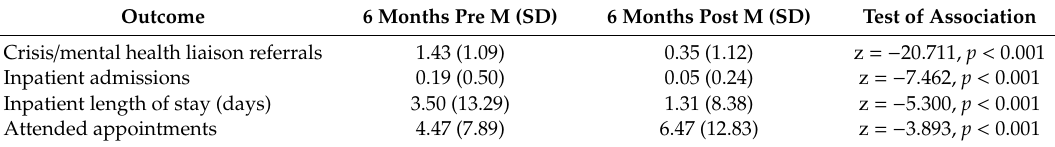
Table 1. An average number of crisis / mental health liaison referrals, inpatient admissions, inpatient length of stay and attended appointments ( n =